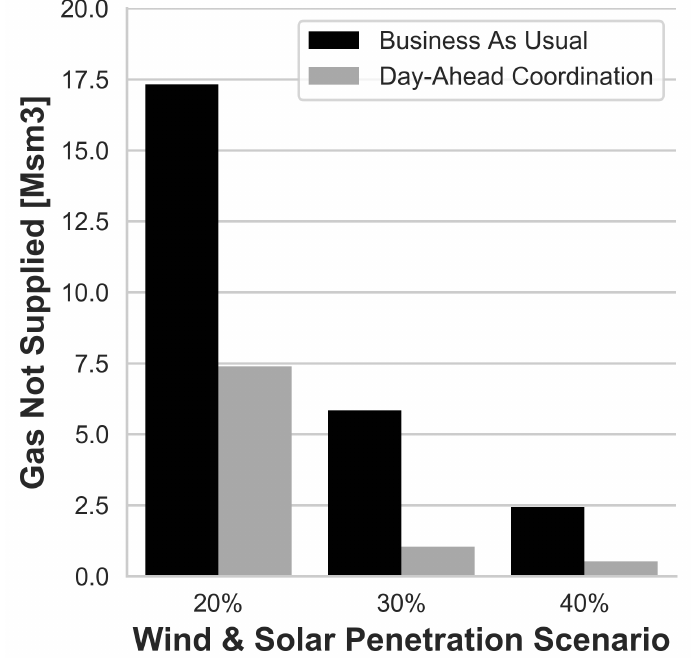
Figure 8. Gas not supplied in the Business As Usual and Day-Ahead (DA) Coordination case. Aggregated results for four weeks (one per quarter) with highest system-wide natural gas offtake ramps.